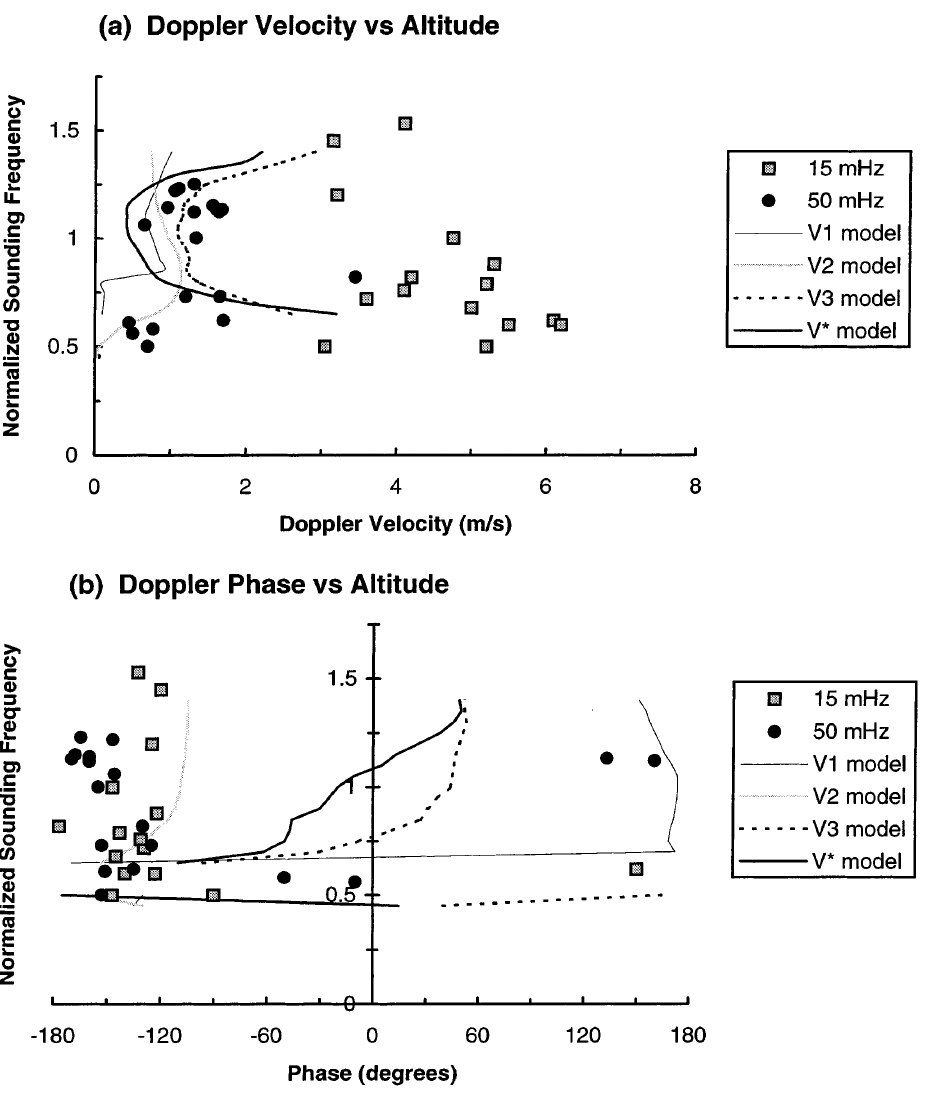
Fig. 11a, b. Variation of a Doppler velocity and b phase with normalized sounding fre- quency (i.e. altitude). Observa- tions for 50 mHz Pc 3 ( solid circles ) and 15 mHz Pc 4 ( squares ) are compared with Sutcli(cid:128)e and Poole (1990)